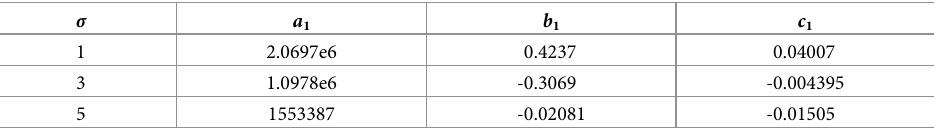
Fitting parameters for initial density generated by simulation with logistic growth. Parameters correspond to those in Eq